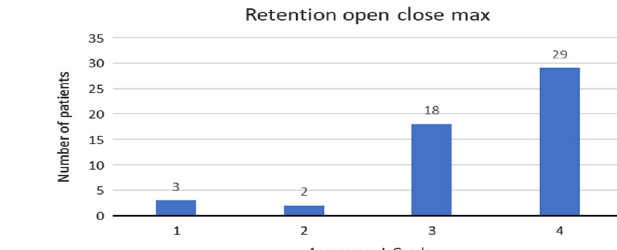
Figure 3. Distribution of sports.